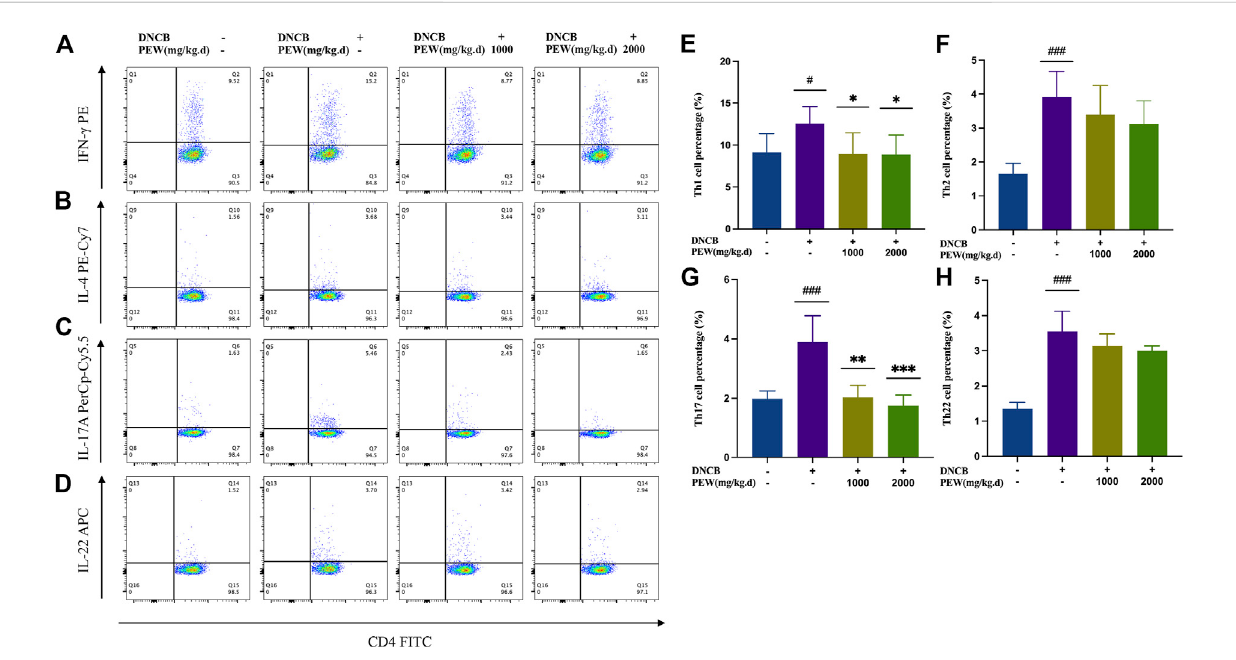
FIGURE 5 PEW decreases the percentage of Th1 and Th17 cells in DNCB-induced AD mice. Splenocytes were collected as single-cell suspension after the miceweresacri fi ced.Thein fl uenceofPEWonthedifferentiationofCD4 + ThcellsinDNCB-inducedADmicewasevaluatedbydetectingtheintracellular expression of IFN- γ , IL-4, IL-17A, and IL-22 using the Flow cytometry assay ( n = 5 – 7/group). (A – D) . Representative images of different Th cell frequencies: (A) Th1, (B) Th2, (C) Th17, (D) Th22. (E – G) .Statisticalanalysisshowedthedifferencesinthepercentagesof (E) Th1, (F) Th2, (G) Th17,and (H) Th22 cells. The data were presented as means ± SD. # p < 0.05, ### p < 0.001, VS. the normal group; * p < 0.05, ** p < 0.01, *** p < 0.001, VS. the model control